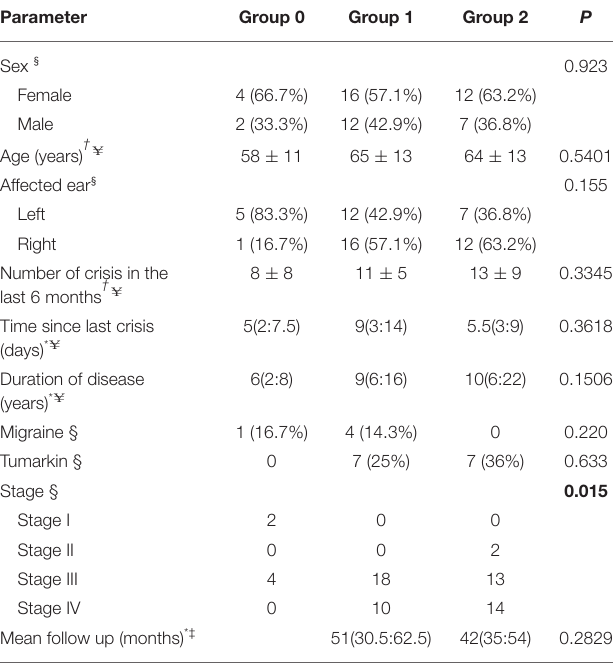
TABLE 1 | Demographic characteristics of the patients.